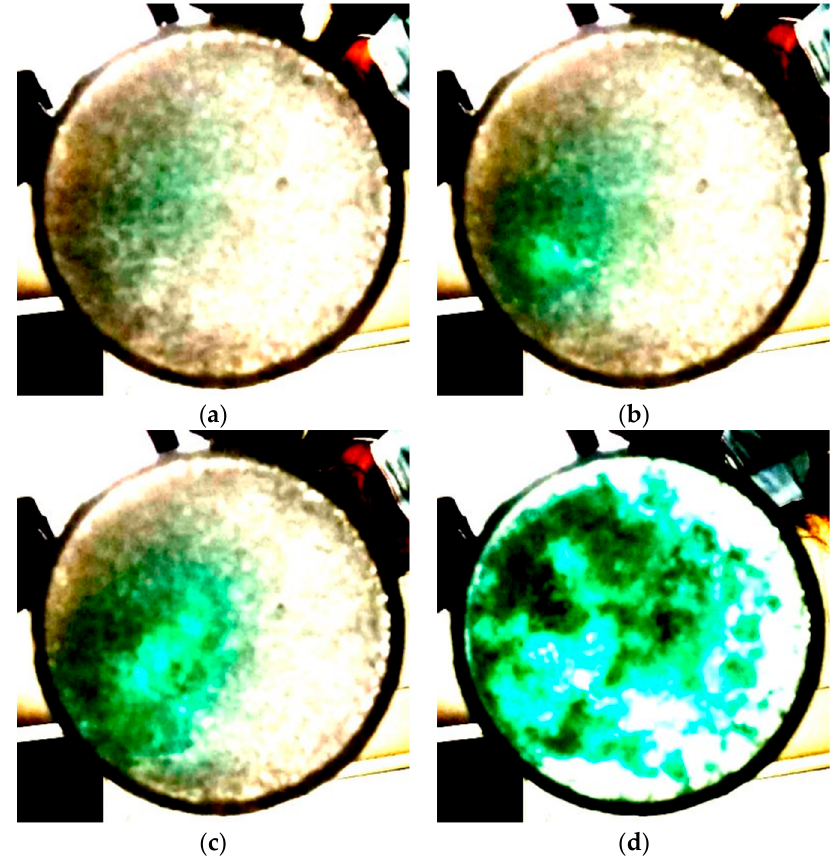
Figure 2. Snow pictures taken from the bottom of the container after uniformly dropping ( a ) 4, ( b ) 7, ( c ) 14, ( d ) 62 pipettes of green-colored water onto the snow top surface. The contrast of the pictures is enhanced to highlight the green-colored areas.